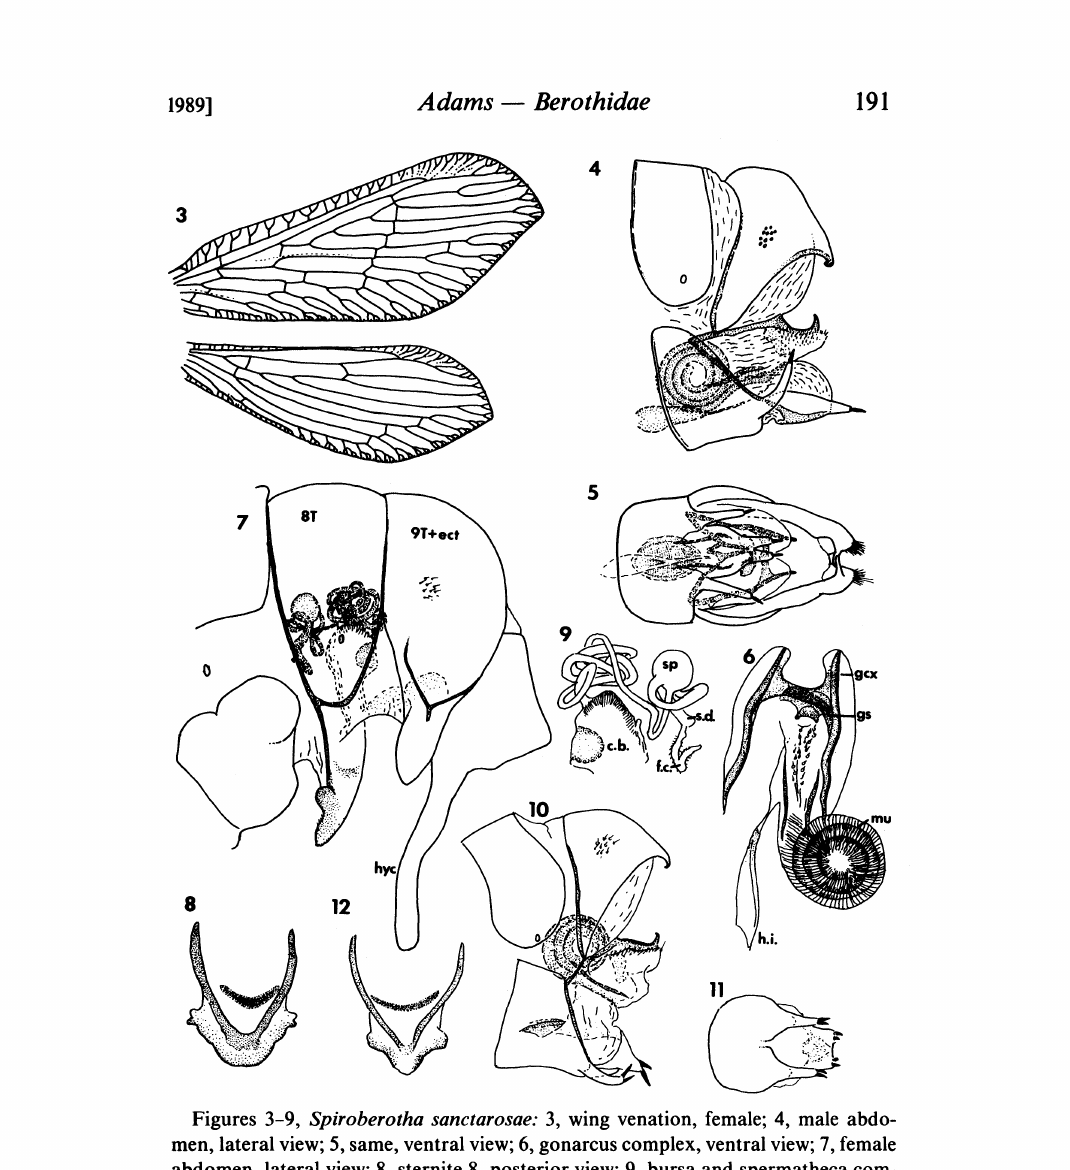
Figures 3-9, Spiroberotha sanctarosae: 3, wing venation, female; 4, male abdo- men, lateral view; 5, same, ventral view; 6, gonarcus complex, ventral view; 7, female abdomen, lateral view; 8, sternite 8, posterior view; 9, bursa and spermatheca com- plex, right lateral view. Figures 10-12. Spiroberotha fernandezi: 10, male abdomen, lateral view; 11, apex of sternite 9, ventral view; 12 female sternite 8, posterior view. Explanation of abbreviations: c.b.--copulatory bursa; ect--ectoproct; f.c.-- fertilization canal; gcx--gonocoxites or entoprocessus; gs--gonarcus; h.i.-- hypandrium internum; hyc--hypocaudae; mu--mediuncus; sd--spermathecal duct;